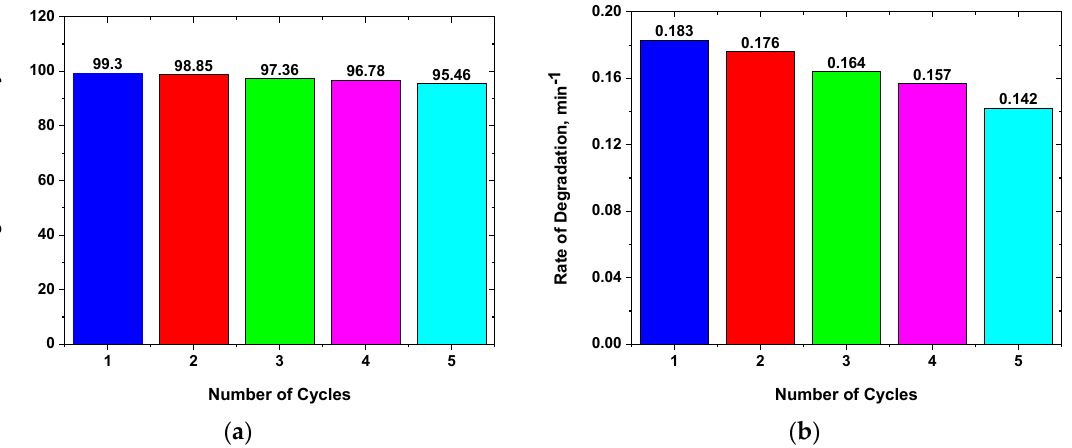
Figure 13. ( a ) Photodegradation efficiency with a number of cycles, ( b ) Rate of degradation with number of cycles, for recycling the catalyst [ZnO:Ag (10%) ].